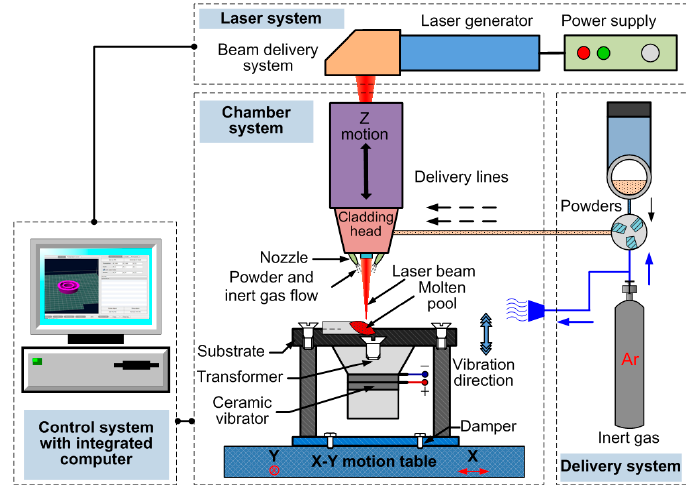
Figure 2. Experimental setup. Table 1. Laser coating parameters.